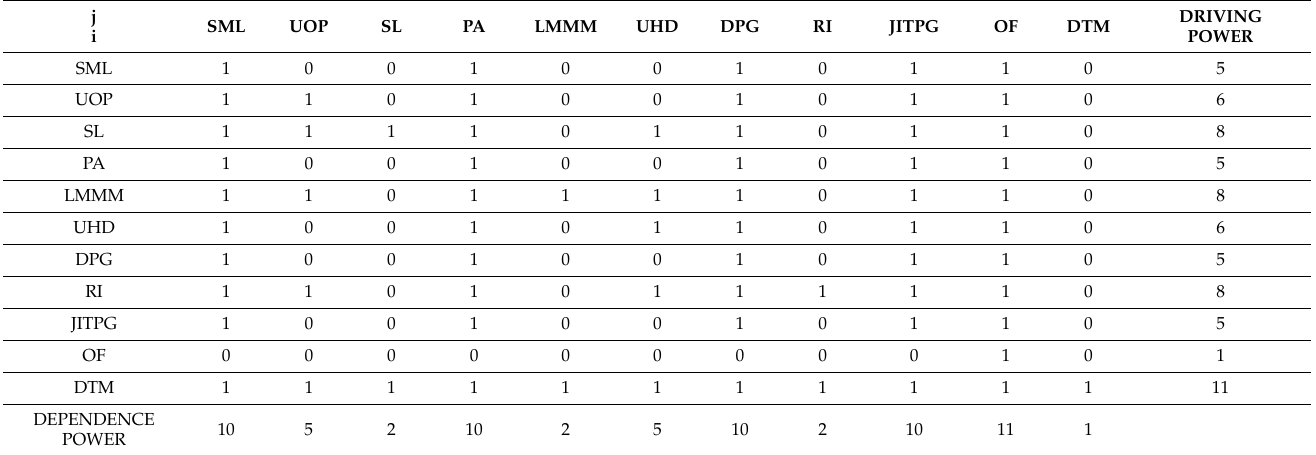
Table 3. Reachability